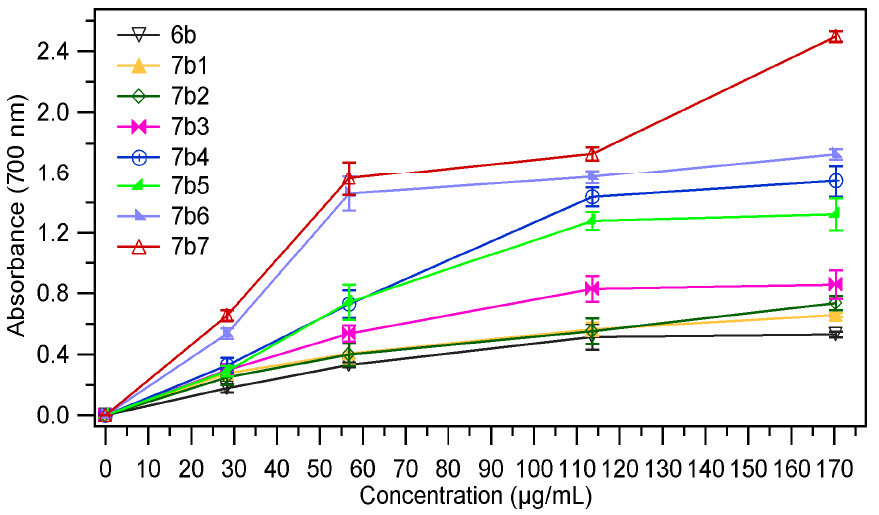
in ref. to 6b . 1–7